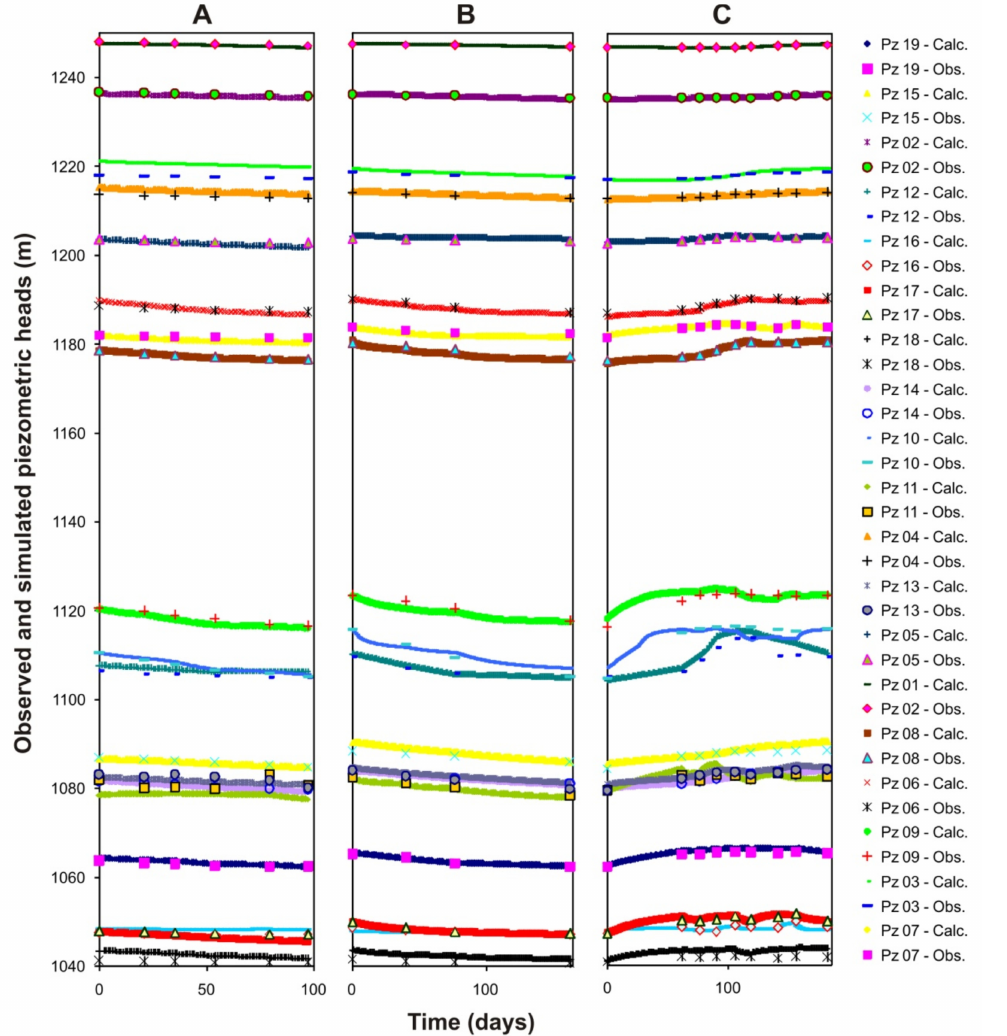
Figure 6. Observed versus simulated piezometric heads for numerical modeling steps of calibration ( A ), verification ( B ), and inverse modeling ( C ).